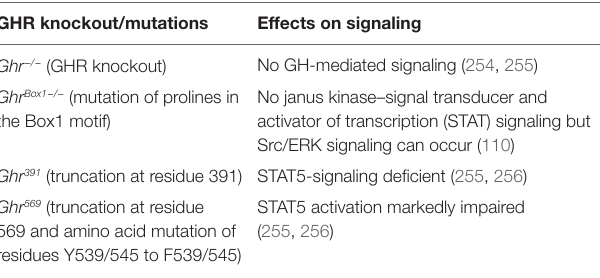
TAble 2 | Growth hormone receptor (GHR) transgenic